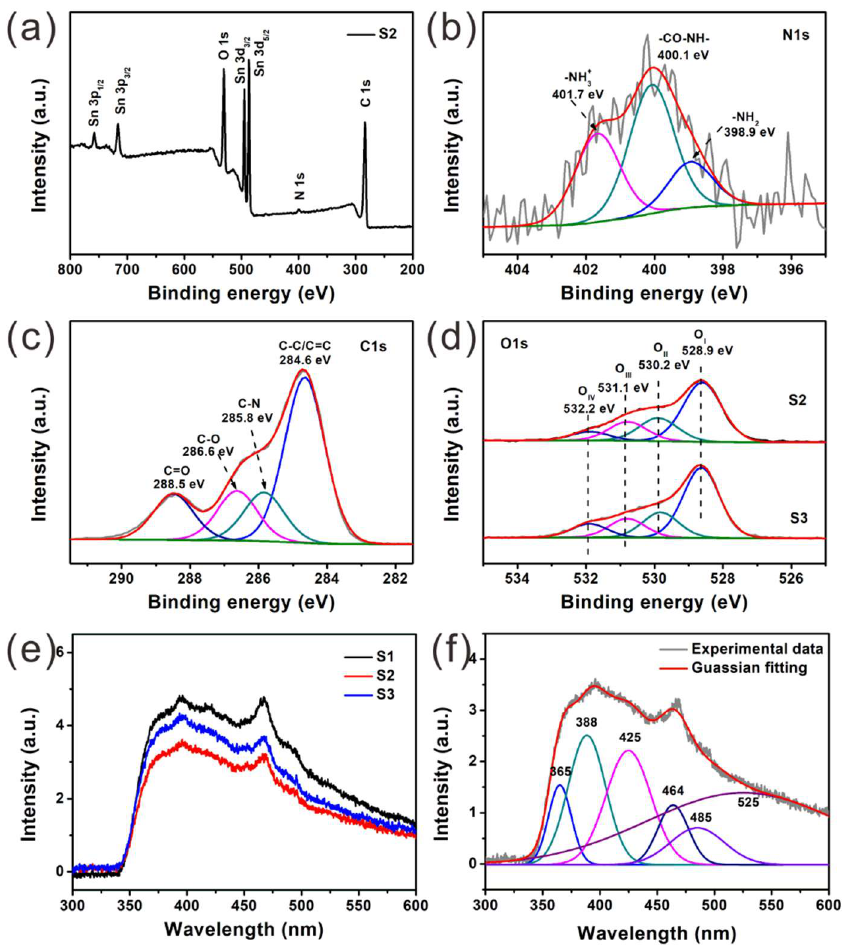
Figure 5. XPS survey spectra ( a ), N1s spectra ( b ), and C1s spectra ( c ) of S2; ( d ) O1s spectra of S2 and S3; ( e ) PL spectra of S1 − S3; ( f ) Gaussian fitting of S2.